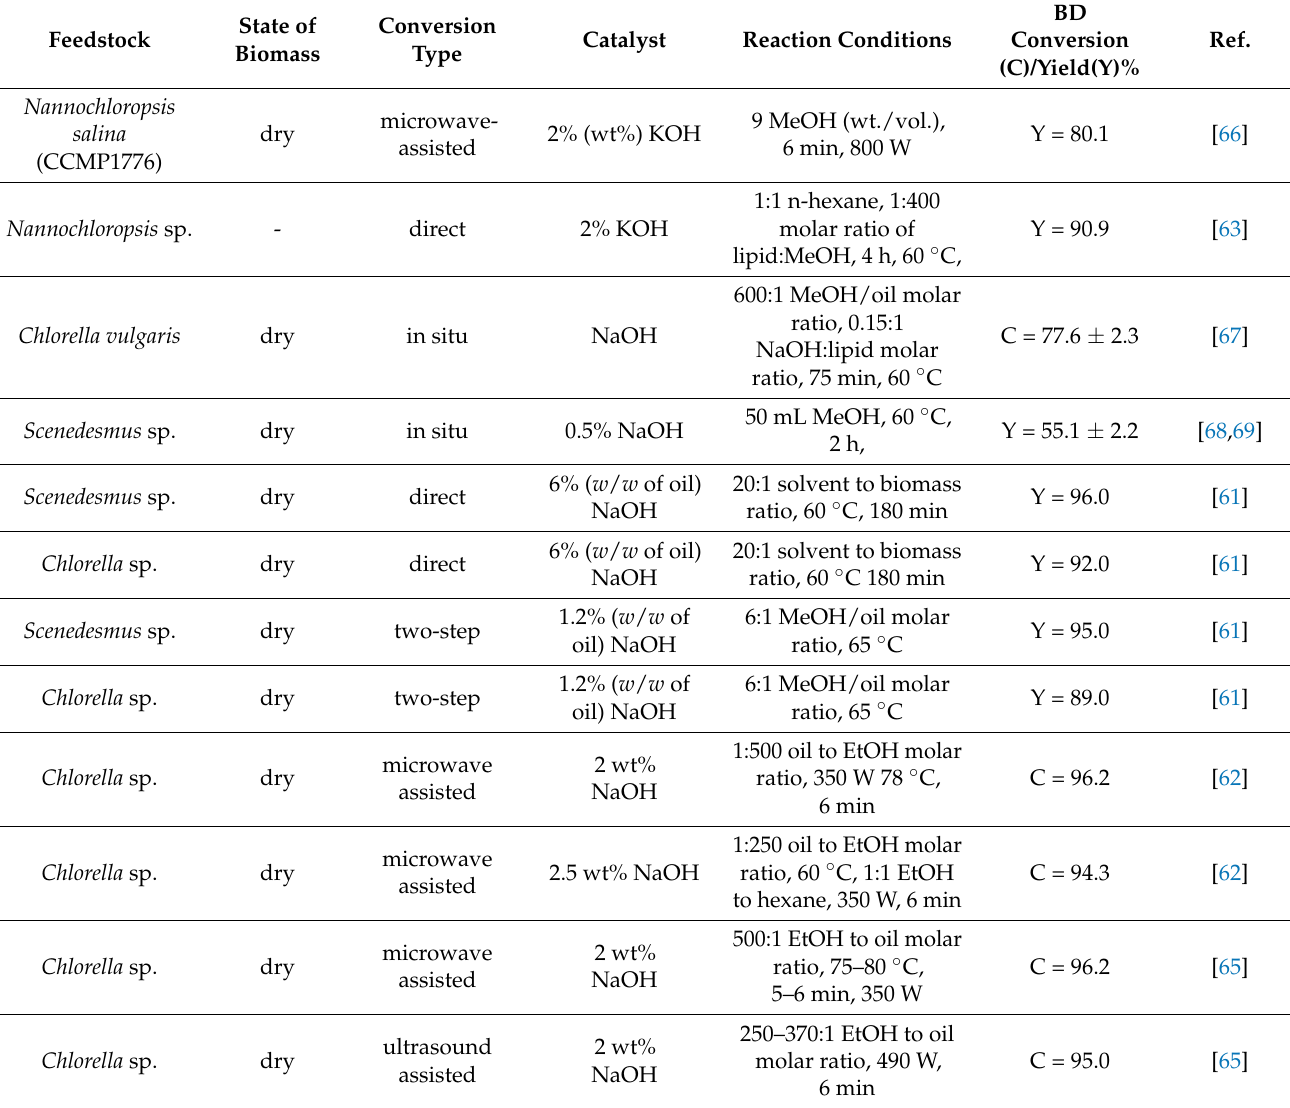
Table 2. Homogeneous alkaline catalysts studied for the transesterification of microalgae